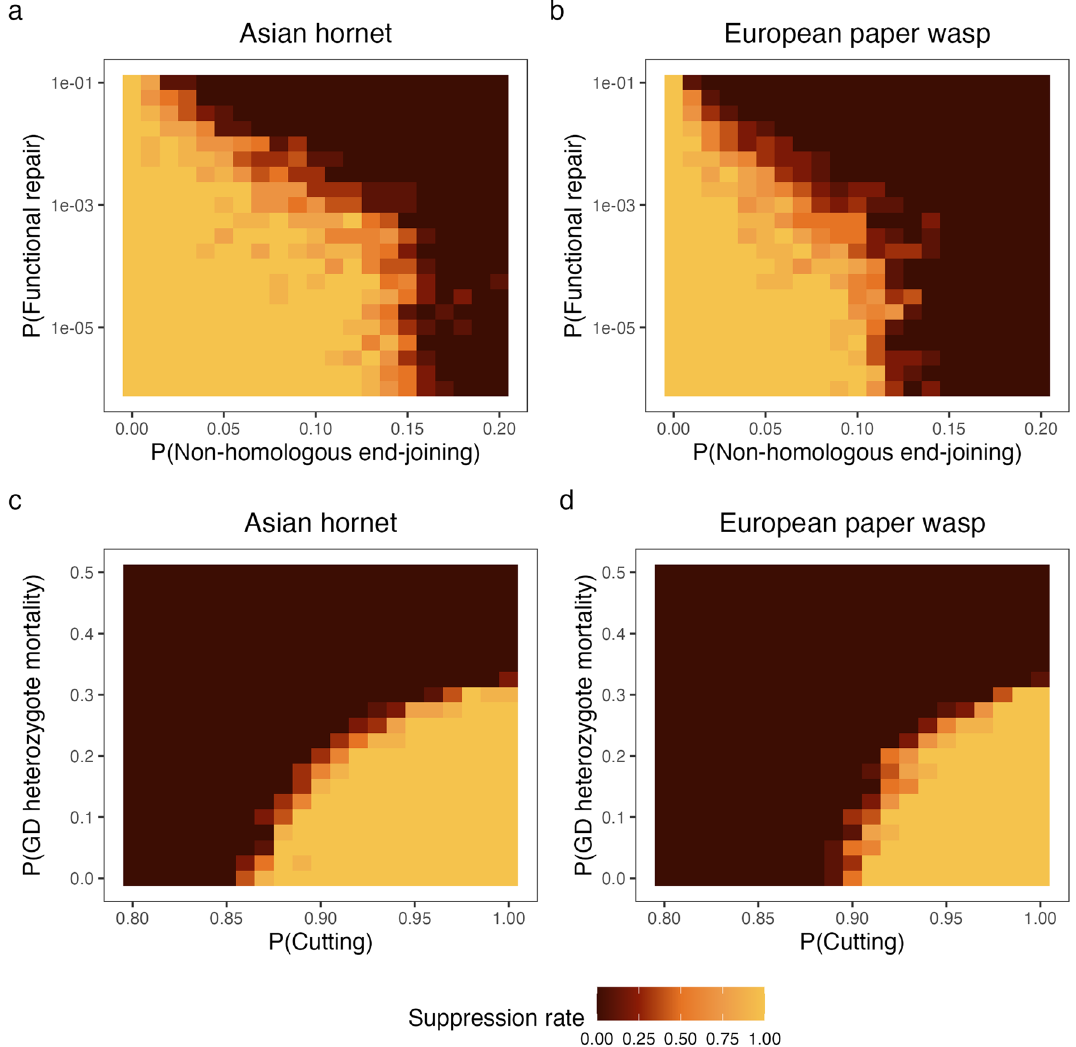
Figure 3. Heatmaps of the suppression rate in the Asian hornet ( a,c ) and the European paper wasp ( b,d ) using gene drives that have varying probabilities of functional repair ( P FR ) and non-homologous end-joining ( P NHEJ ), or cutting ( P cut ) and mortality of gene drive heterozygotes ( P HetMort ). Note that the model was run for 50 generations instead of 25 to reduce the noise and better allow the different scenarios to (Fig. 4a), and the time to suppression is lower (Fig. 4b). We mostly see changes in the suppression rate, as opposed to only slight changes in the time to suppression. In both species, mean male matings, max male matings, number of progeny, and winter mortality have a strong effect on the efficacy of the gene drive. In all these cases, except for winter mortality, increasing the parameter leads to a decrease in the efficacy of the gene drive. Changing the max growth rate and the max and mean female matings did not show a clear effect on the suppression rate in either species. One life history trait that differs between both species we did not fully capture in our sensitivity analysis is polyandry, which is a queen mating with multiple males. This trait is a combination of mean female matings and max female matings, an interaction we did not explore as we only looked at first order effects. While the Asian hornet is a highly polyandrous species, the European paper wasp is not. To untangle the effects of polyandry on the success of the gene drive, we modeled the Asian hornet without polyandry, and the European paper wasp with doubled polyandry (Supplementary Fig. S3). We increased the paper wasp mean female mating rate from the default 0.2 to 0.4, and increased the max female matings to 4. For the Asian hornet, we decreased the max female matings to 1. As the distribution of female matings is zero truncated, this effectively brought the mean female matings to 1 as well. Removing polyandry from the Asian Hornet strongly reduces the efficacy of the gene drive (Supplementary Fig. S3a). In the case of a gene drive targeting female infertility using female release, suppression decreases from 64 to 20 out of 100 repetitions. When using male release for female infertility, suppression did not occur anymore. This is in line with the trend suggested by decreasing the max female matings in Fig. 4a. However, we do not see a clear positive effect of adding polyandry to the European paper wasp on the efficacy of the gene